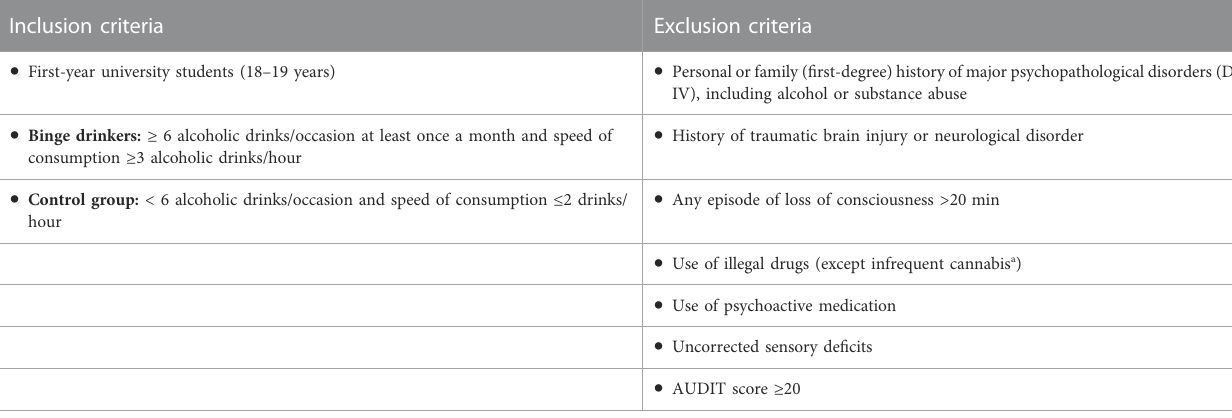
TABLE 1 Inclusion and exclusion criteria for sample selection, based on interview.